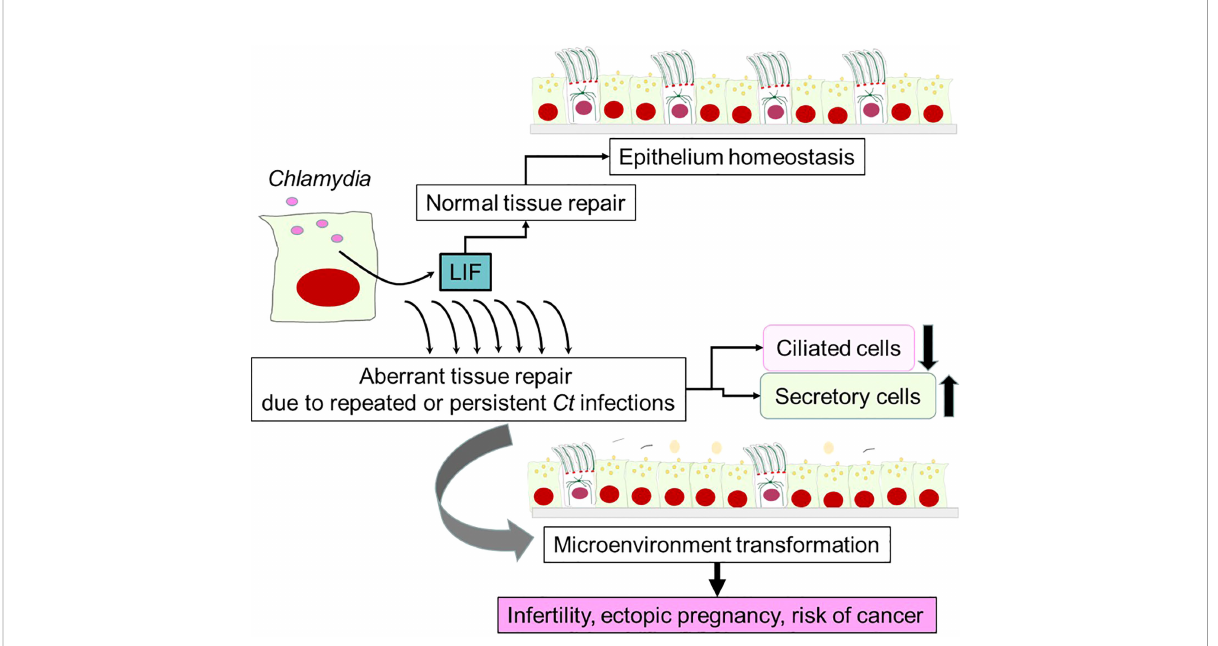
FIGURE 4 A potential role of LIF in Chlamydia pathogenesis. LIF is produced by epithelial cells upon Ct infection, which is required for maintaining epithelium homeostasis and normal tissue repair via autocrine LIF/LIFR signaling pathways. This would occur in many Ct- infected women without leaving serious complications. However, aberrant tissue repair is triggered by repeated or persistent infections, which results in marked reductions of ciliated epithelial cells and increases in secretory cells over time. The alteration in the cellular composition creates a microenvironment in fallopian tubes that may promote infertility, ectopic pregnancy and